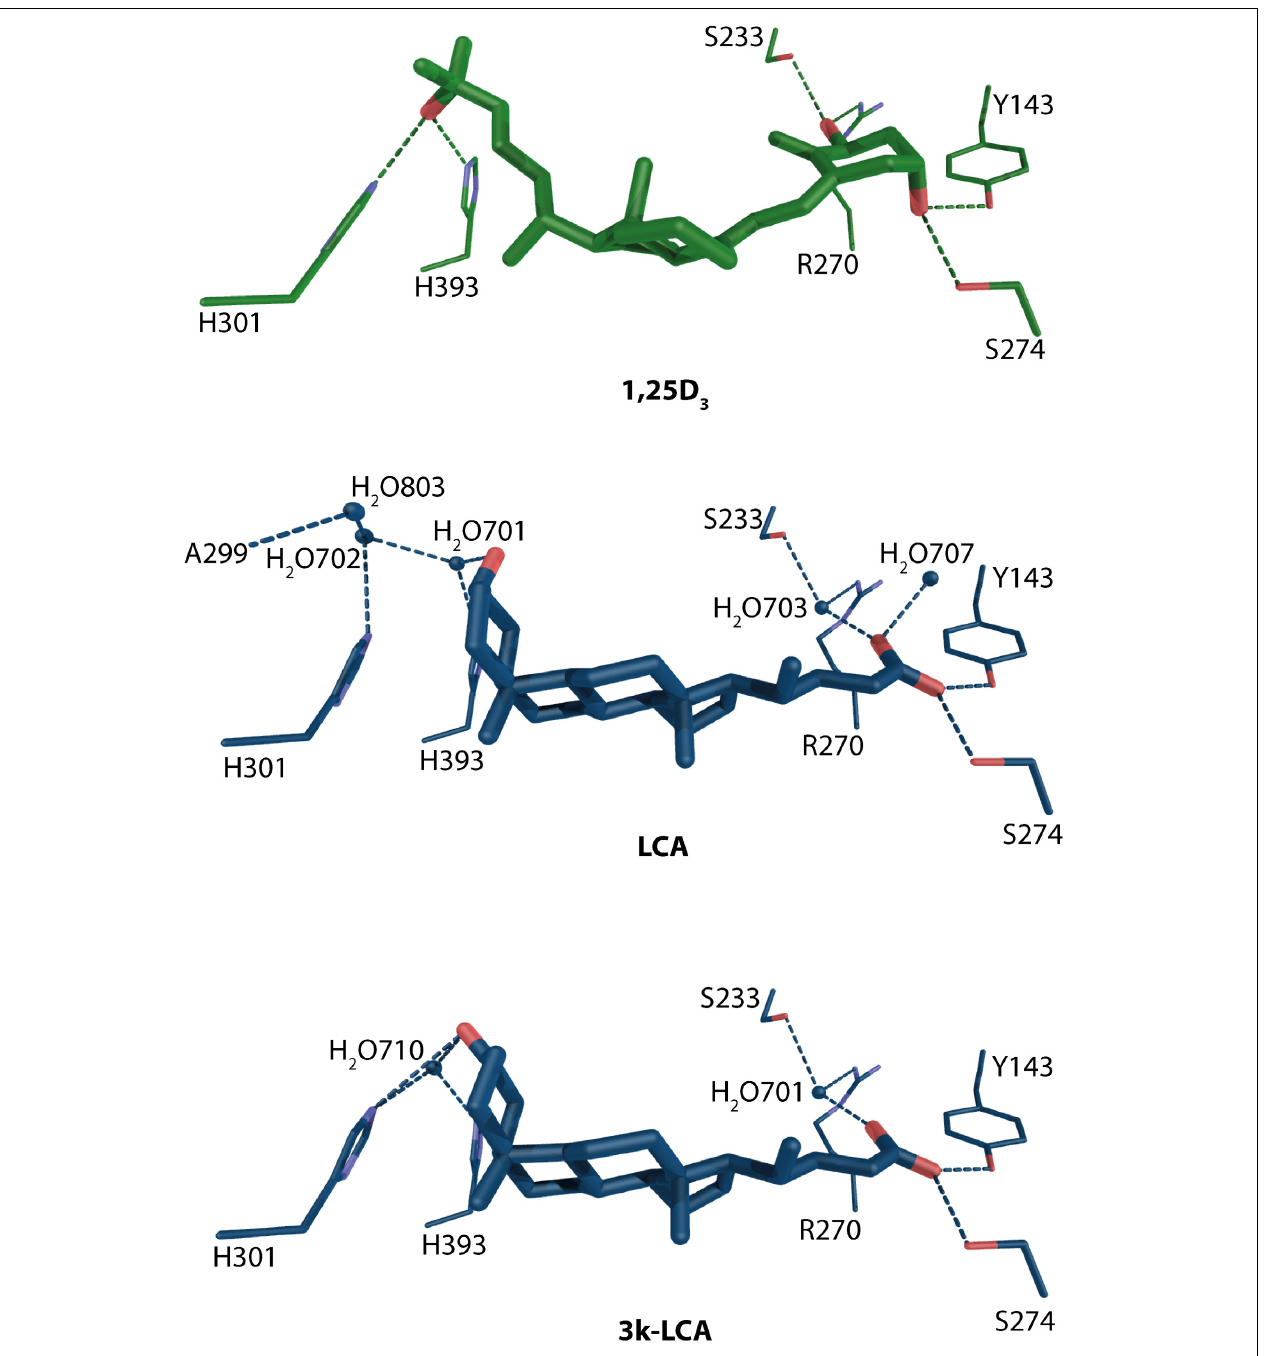
FIGURE 6 | Binding mode of 1 α , 25-dihydroxyvitamin D 3 , lithocholic acid and 3-ketolitocholic acid in the LBP of rat VDR (source PDBID: 1RK3, 3W5P, and 3W5Q). 1,25D 3 and LCA/3kLCA and are highlighted in green and blue color, respectively. The hydrogen bonds are in green and blue dashed